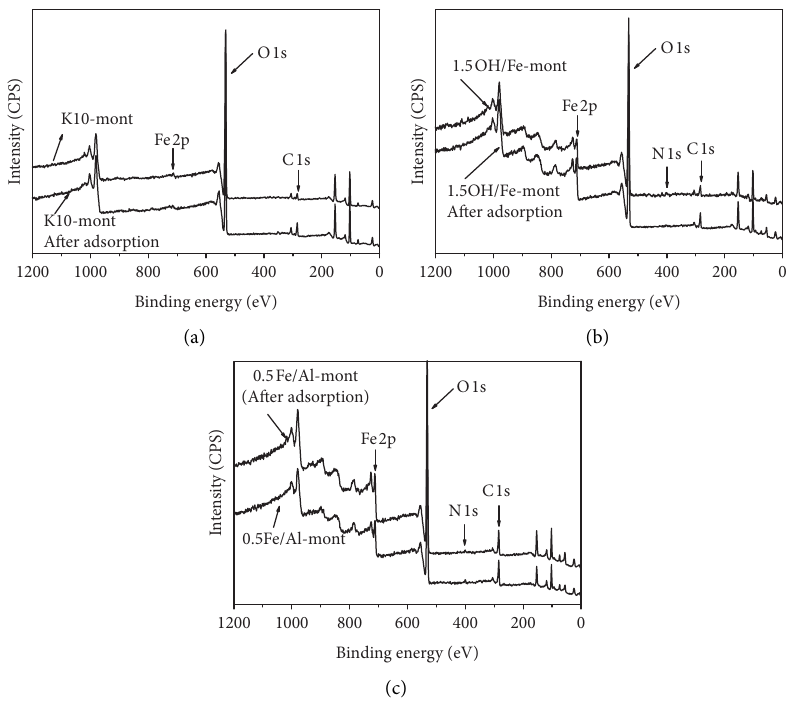
Figure 5: X-ray photoelectron spectra of pillared